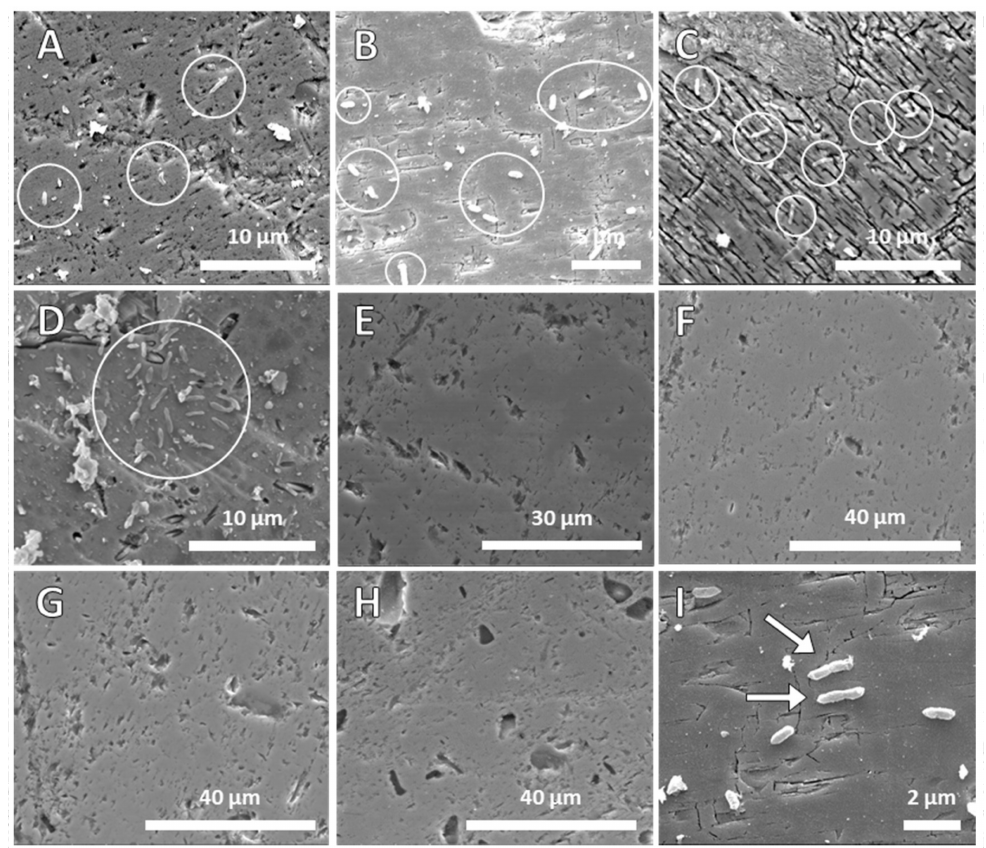
Figure 1. SEM micrographs of pyrite tiles exposed to A. ferrooxidans (indicated by circles) for ( A ) 2 h; ( B ) 24 h; ( C ) 72 h; ( D ) 168 h: pyrite tiles exposed to HH medium for ( E ) 2 h; ( F ) 24 h; ( G ) 72 h; ( H ) 168 h; ( I ) SEM micrograph of A. ferrooxidans cells in the process of cell division at 24